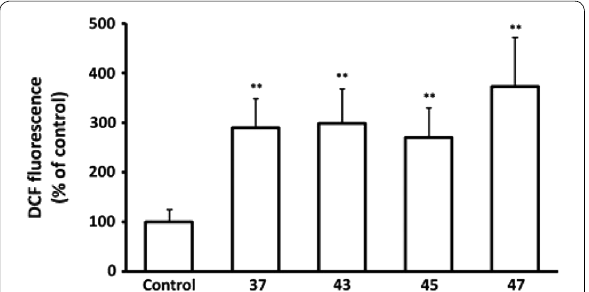
Fig. 2 Oxidative stress of HT‑1080 cells following rhodanine treat‑ ment. Cells were incubated with the indicated compounds (10 μM) or the corresponding concentration of vehicle (control). Intracellular ROS were determined after 48 h using the DCFH‑DA method. Results represent the mean standard deviation of three independent ± experiments (**p <